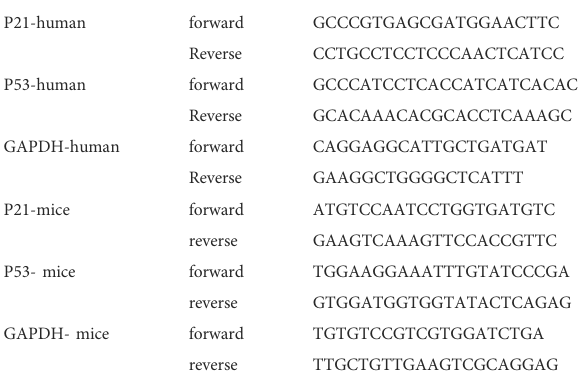
TABLE 1 Primers used for the real